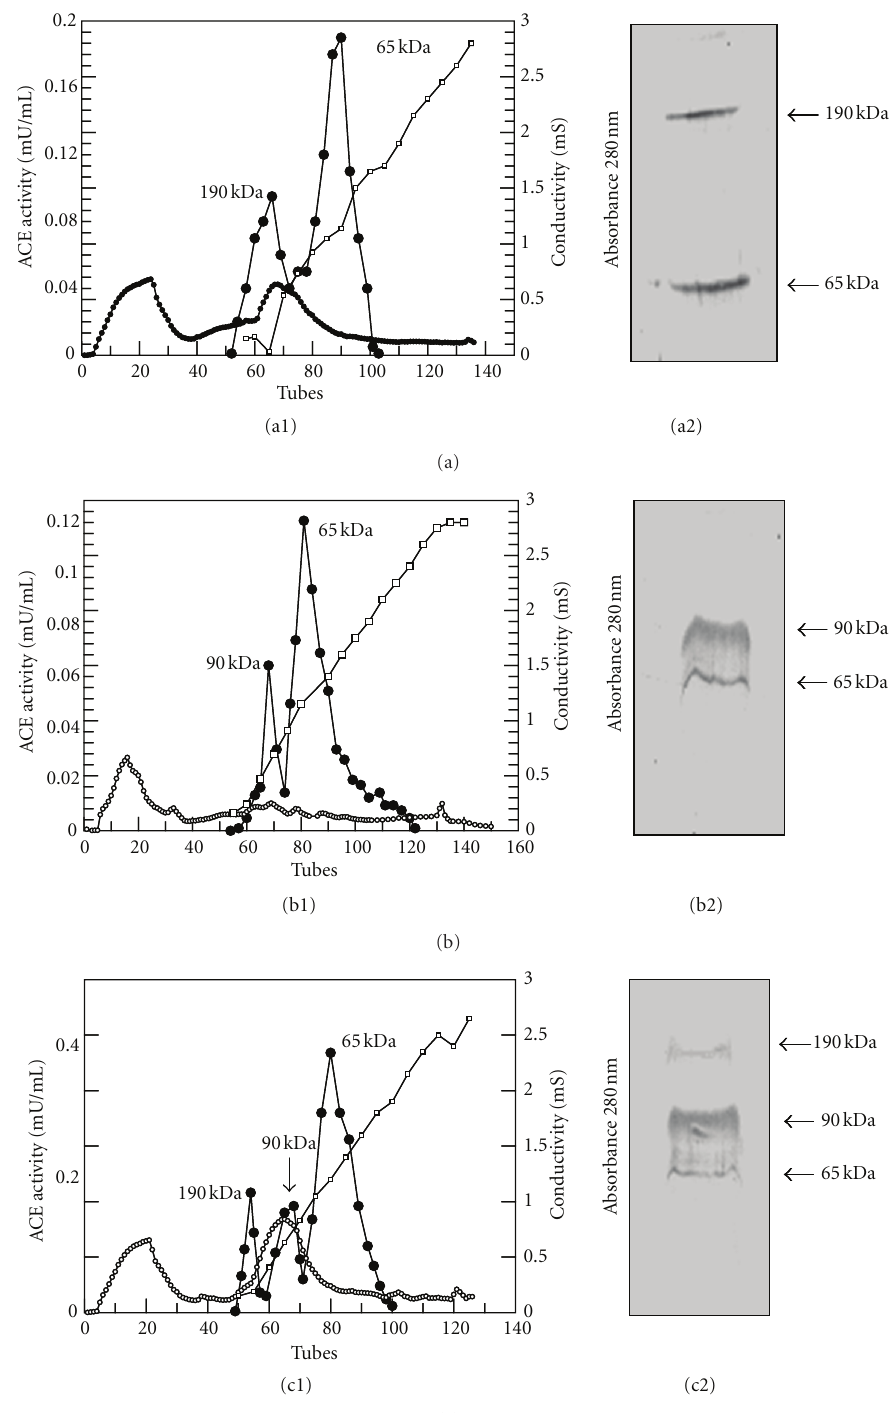
Figure 1: Chromatography of human urine from normal and hypertensive subjects on DEAE-cellulose. (a1) Normotensive subjects with two peaks with ACE activity corresponding to 190 and 65kDa ACE; (b1) Hypertensive subjects with two peaks with ACE activity corresponding to 90 and 65kDa ACE; (c1) Normotensive subjects with three peaks with ACE activity corresponding to 190, 90, and 65kDa ACE. The dialyzed human urine (100 mL) was applied to a DEAE-cellulose column (1 . 5 × 10 cm). The column was washed with 20 mM Tris/HCl bu ff er, pH 7.0, and then eluted (fractions of 4.5mL) with a linear gradient of 20mM to 500mM Tris/HCl bu ff er, pH 7.0, at a flow rate of 55mL/h. ( ◦ ) Absorbance at 280nm. ( • ) ACE activity with HHL as substrate. ( (cid:2) ) Conductivity. Werstern blotting analysis of urinary ACEs. (a2) Normotensive subjects with 190 and 65 kDa ACE; (b2) Hypertensive subjects with 90 and 65 kDa ACE; (c2) Normotensive subjects with 190, 90, and 65kDa ACE (as described in Section